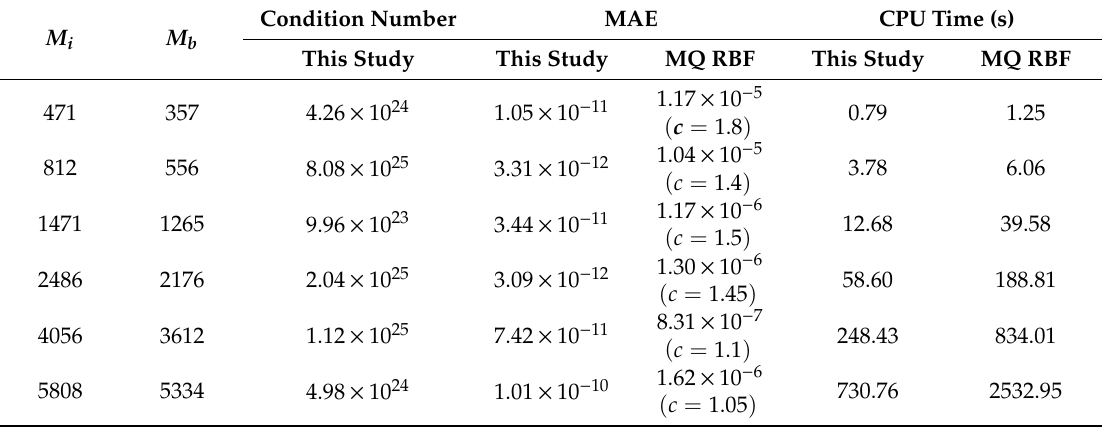
Figure 3. Results comparison between this study and the analytical solution. Table 1. Results comparison between this study and the multiquadrics radial basis function with the optimal shape parameter.